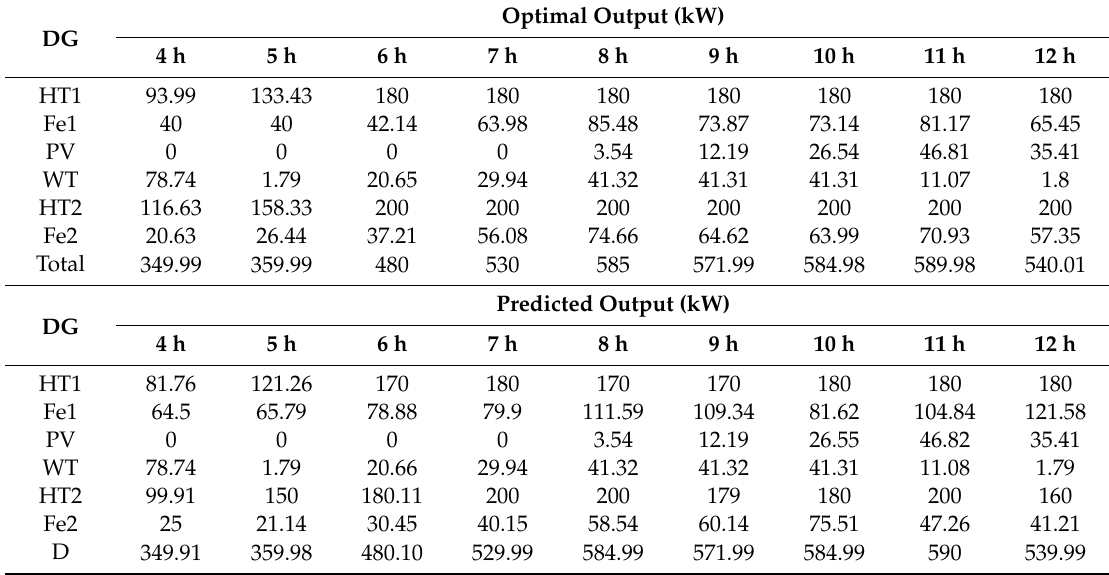
Table 4. Results comparison of hours in a